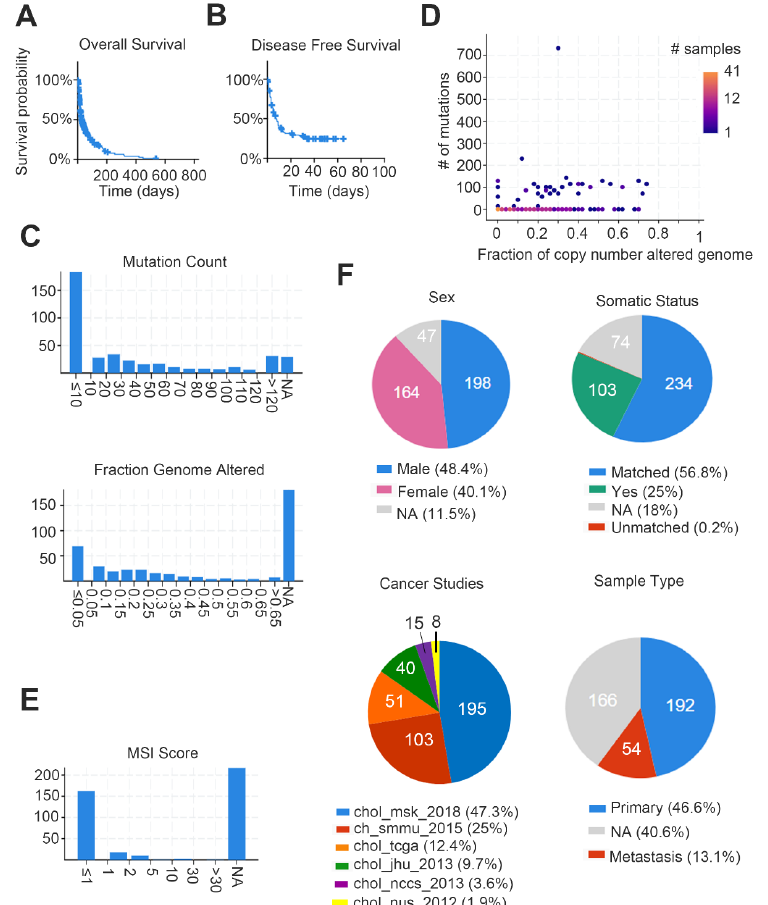
Figure 1. Meta-analysis of cholangiocarcinoma (CCA) demographics and clinical events. Study recruited six cohorts, including MSK, National Cancer Center of Singapore, National University of Singapore, TCGA, JHU and Shanghai) with a total of 409 patients (412 samples). We summarized the clinical information through the cBioPortal website. ( A ) Average overall survival probability in the study; ( B ) average disease-free survival rate in the study; ( C ) ratio of mutation counts and the range of changes in the number of genome alters, Y-axis = samples; ( D ) proportion graph indicates the ratio of mutation counts and the range of changes in the number of genome alters; ( E ) range of microsatellite instability (MSI) scores in the study, Y-axis = samples; ( F ) circle graphs show percentage of various clinical parameters in the study.